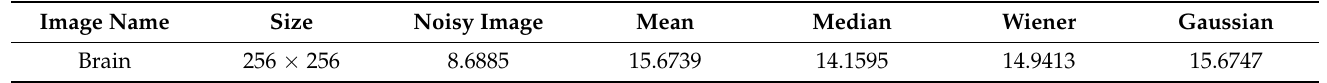
Table 5. MRI image under four classical filtering algorithms for PSNR